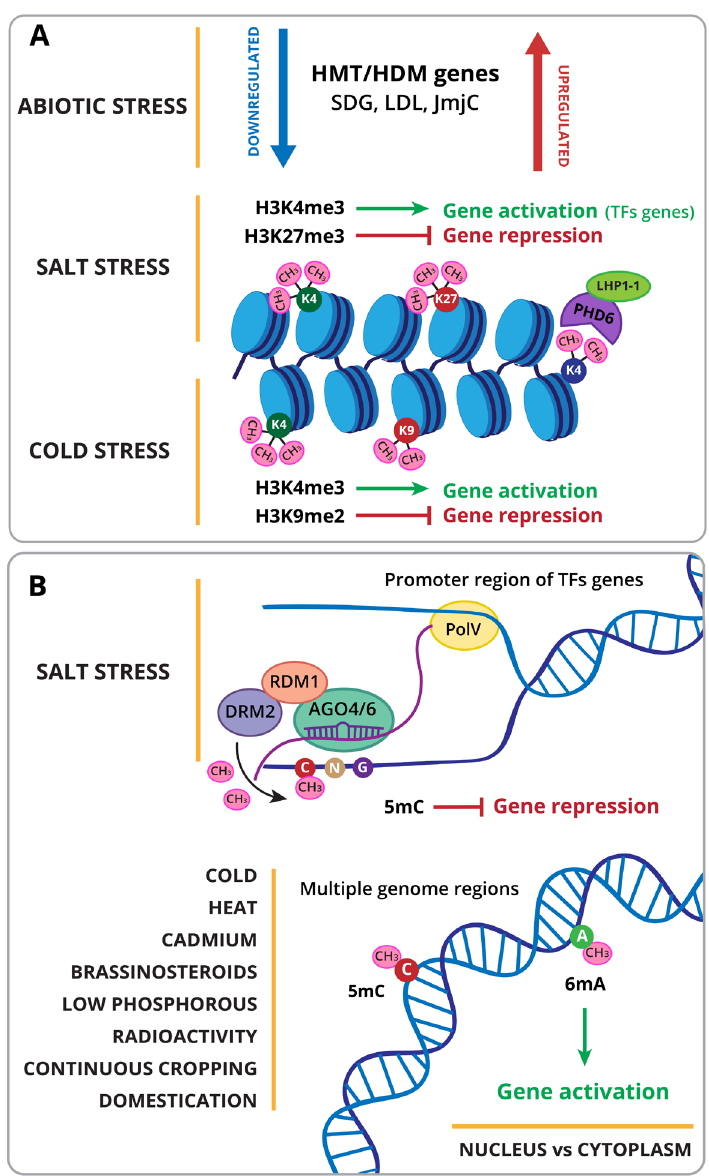
Figure 4 – Methylation as epigenetic regulators in soybean under abiotic stress. ( A) Histone methyltransferases (HMT) and demethylases (HDM) can be either increased or reduced under stress. Under salt stress: activation of transcription factors (TFs) was correlated with a higher level of histone H3K4me3 and gene inactivation with the H3K27me3. Under cold stress H3K4me3 activation and H3K9me2 repression mark were observed. Plant homeodomain fingers 6 (PHD6) reads low methylated histone H3K4me0/1/2 but not H3K4me3. Upon binding to low methylated histones, the amino- terminal region of PHD6 interacts with its LHP1-1/2 coactivator to form a transcriptional activation complex. (B) Promoter regions of TFs genes are differentially methylated on DNA under salt stress. Differential DNA methylation was observed in soybean under cold, heat, cadmium, brassinosteroids, low-phosphorus, radioactivity, continuous cropping stress and